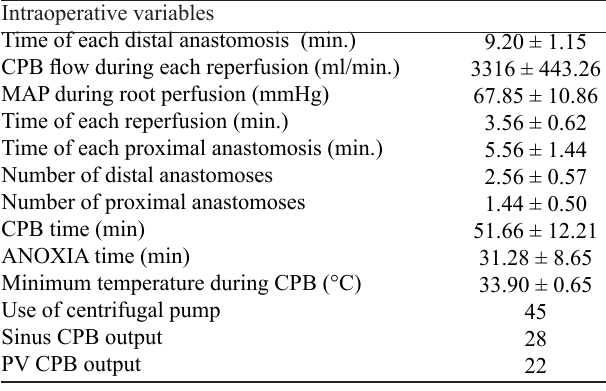
Table 2. Intraoperative variables Intraoperative